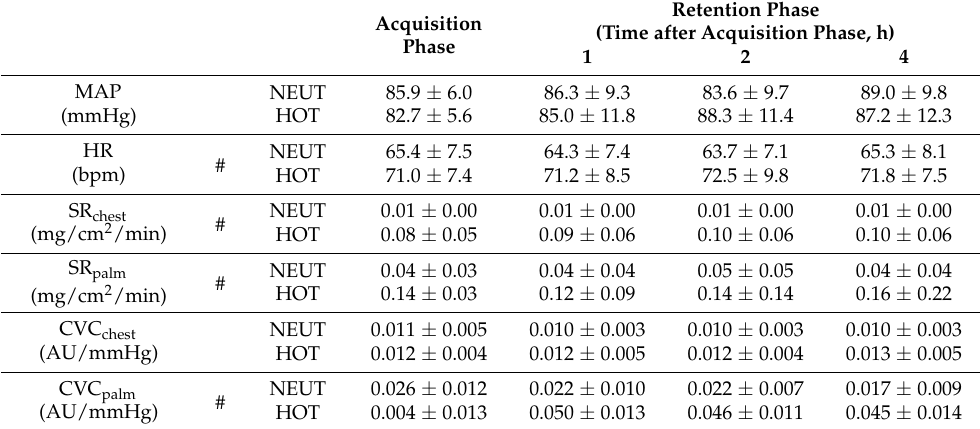
Table 1. Physiological variables at rest before VAT task.